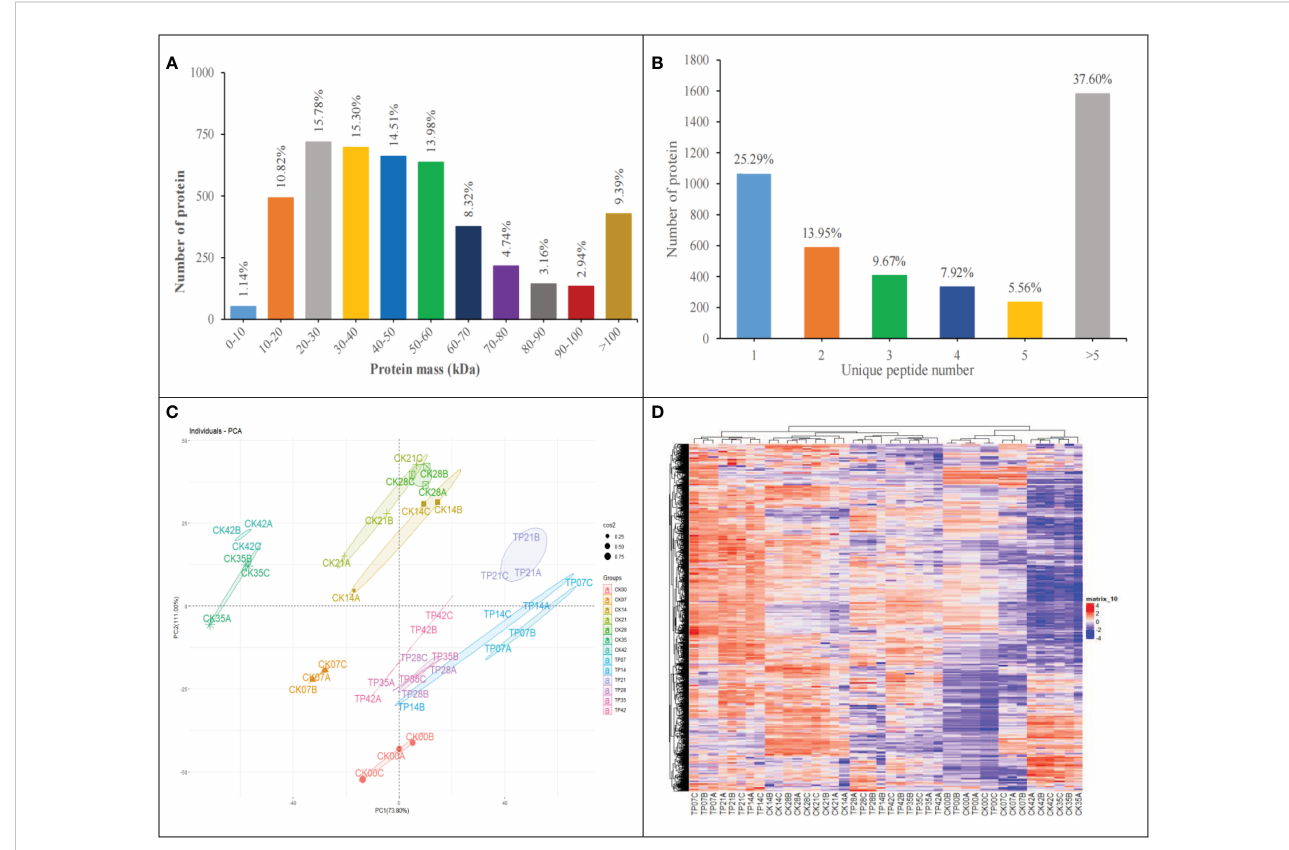
FIGURE 3 Molecular weight distribution plot of all identi fi ed proteins (A) . Distribution of proteins containing the different number of identi fi ed unique peptides (B) . Principal component analysis of protein expression patterns (C) . Heatmap of the 4457 identi fi ed proteins, different columns represent independent biological replicates (D)